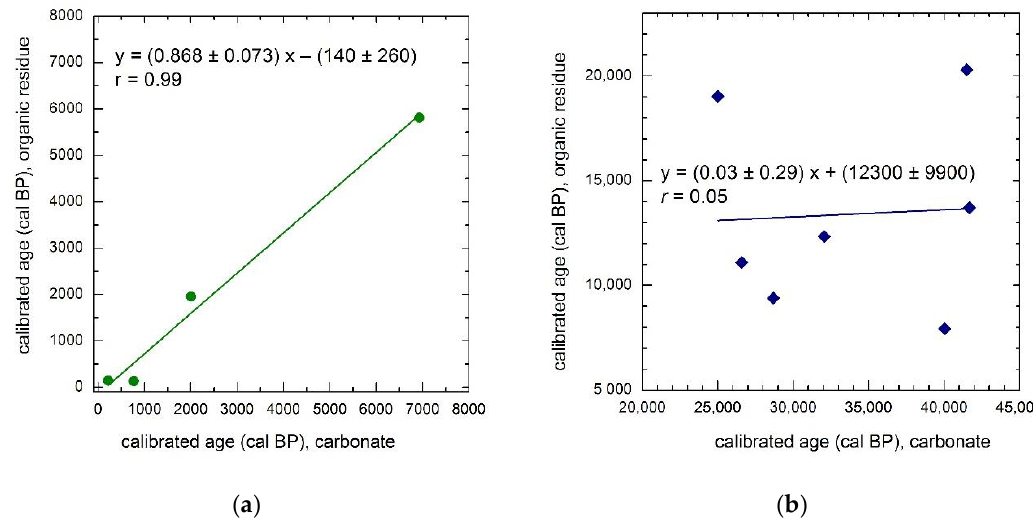
Figure 4. Calibrated ages of the organic residue vs. calibrated ages of the carbonate component of the tufa samples from Sanaderi. ( a ) the Holocene samples; ( b ) the “old” samples.